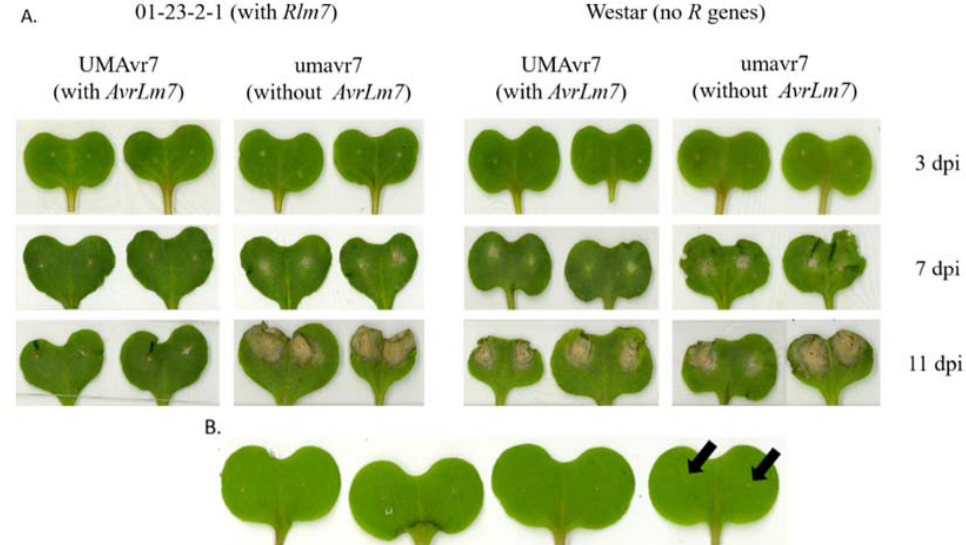
Figure 1. Phenotypic responses of Rlm7 line (01 ‐ 23 ‐ 2 ‐ 1) and Westar to the infection of UMAvr7 and umavr7 at 3 ‐ , 7 ‐ , and 11 ‐ days post inoculation under controlled conditions. ( A ) UMAvr7 isolate with AvrLm7 and umavr7 isolate without AvrLm7 were inoculated to the Rlm7 line and Westar. Necrotic lesion development at 3 ‐ , 7 ‐ , and 11 ‐ dpi are shown. ( B ) Mock experiment. The arrows indicate the inoculated sites.